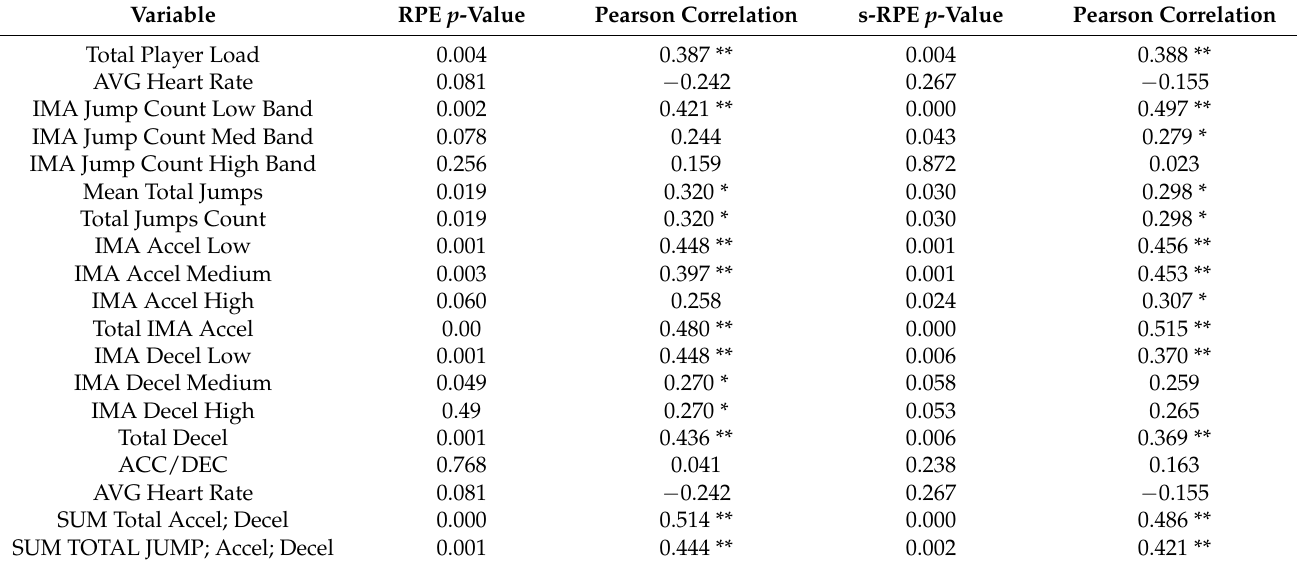
Table 4. Relationships between RPE and s-RPE and kinematic parameters in the